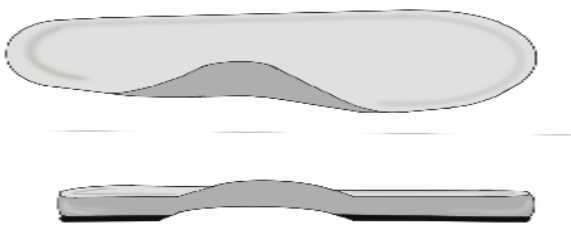
Figure-V: A top-view of the insole (a hump acts as a support to uplift the foot arches).